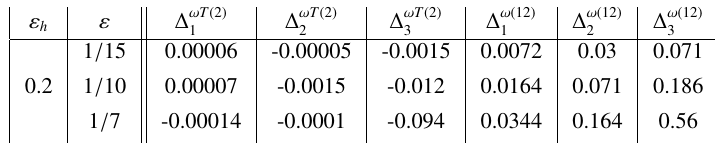
Table 1. Relative di ff erences for homogeneous beam, ν = 0 .